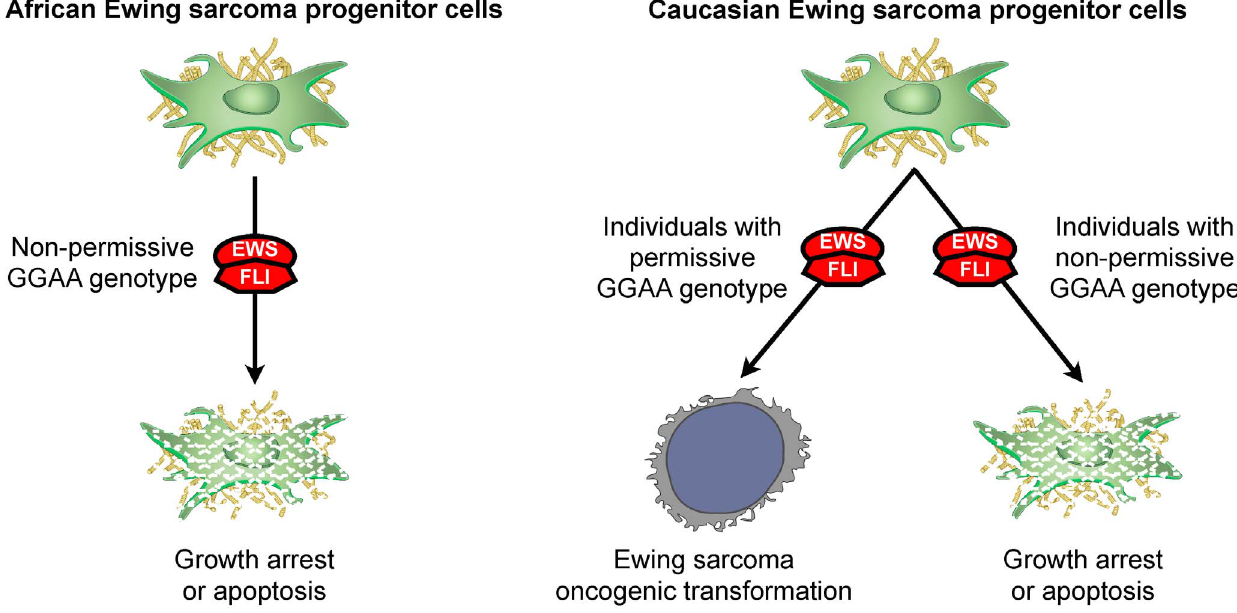
Figure 7. Model of GGAA-microsatellite polymorphism contributions to Ewing sarcoma susceptibility in African and white European populations.